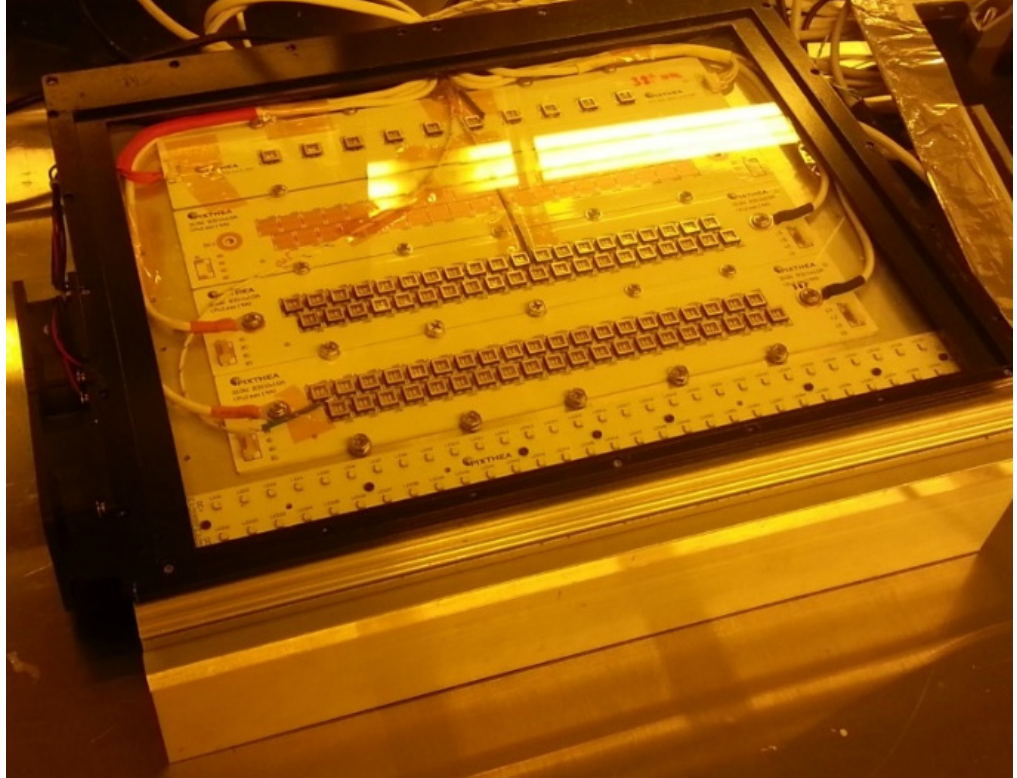
Figure 1. Schematic diagram of the high-power UV-LED module system.